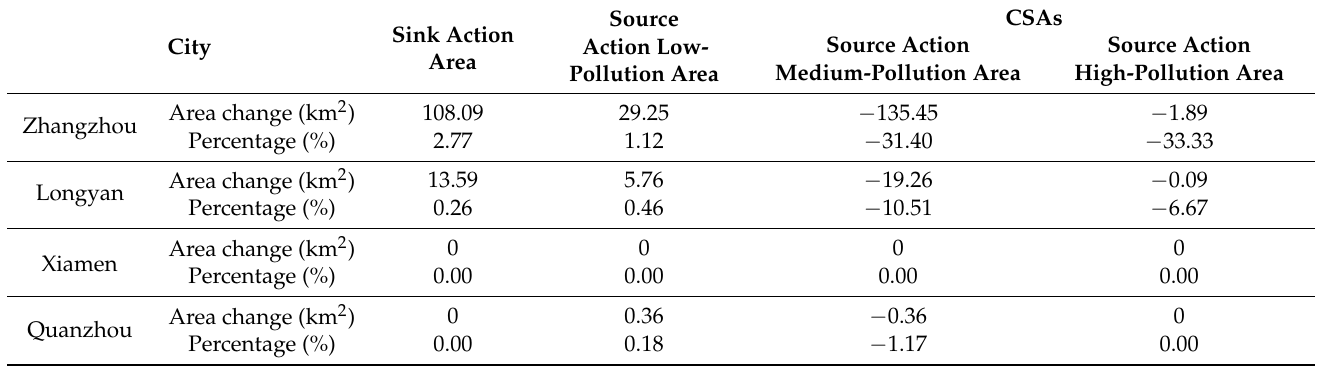
Table 6. The area changes of NPS pollution CSAs in the cities of the Jiulong River watershed after